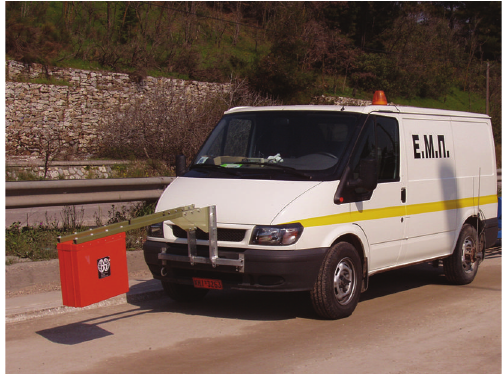
Figure 8: NTUA GPR horn antenna system used for the experi- ment.